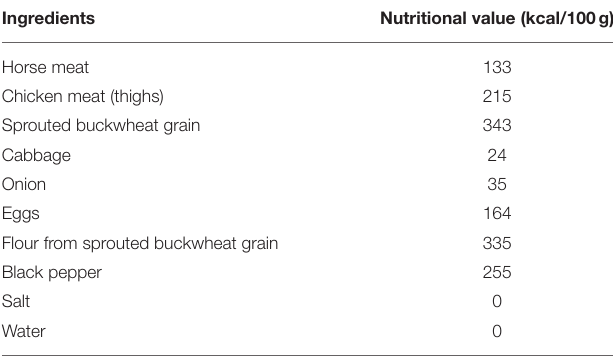
TABLE 1 | The list of ingredients and their nutritional values in patties. Ingredients